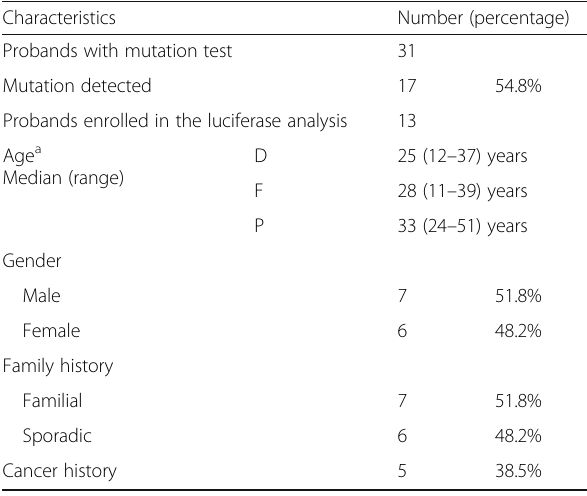
Table 1 Characteristics of the cohort with PJS